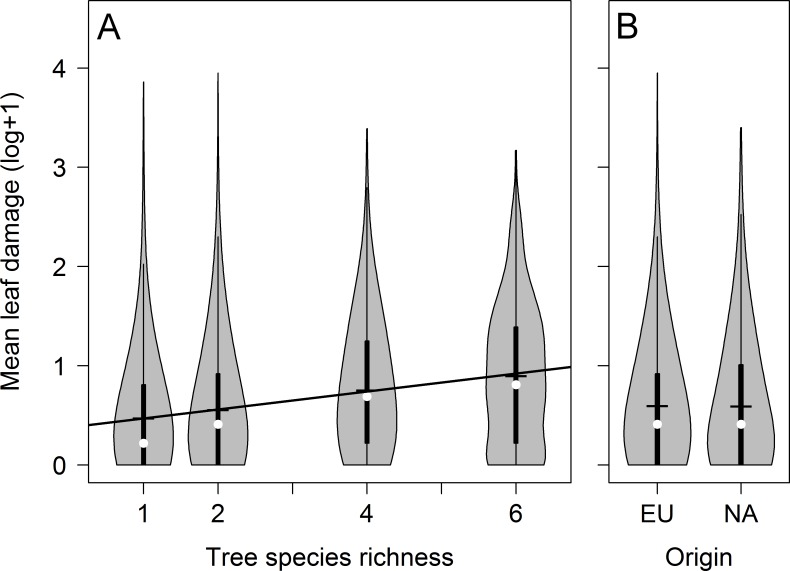
Leaf damage by chewing insects.(A) Relationship between leaf damage and tree species richness. The solid line illustrates the prediction of a linear model (significant at P < 0.05). (B) Comparison of leaf damage on native European (EU) and exotic North American (NA) trees. The data are log(x+1)-transformed mean damage values per tree individual and presented as violin plots that combine a boxplot with a kernel density plot; medians and means are, respectively, indicated by white dots and horizontal black lines.